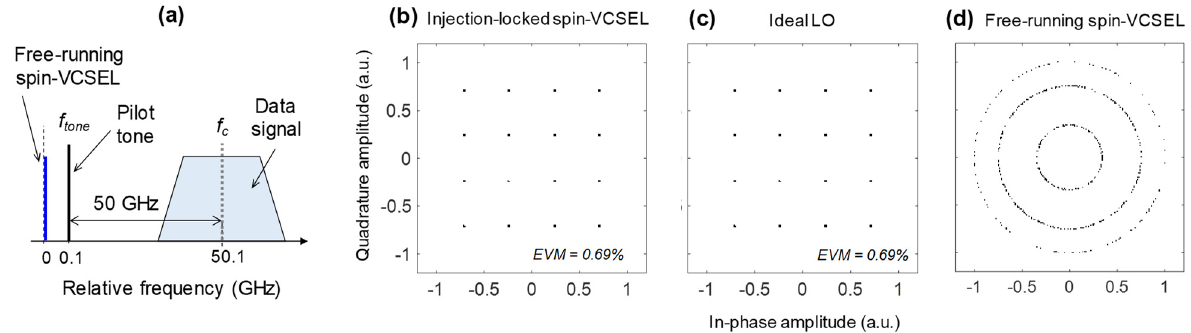
Figure 6. ( a ) Schematic relation among f c , f tone , and data signal. Constellation diagrams of detected 25-Gbaud 16-QAM signals. ( b ) With injection-locked spin-VCSEL; ( c ) With ideal LO; ( d ) With free-running spin-VCSEL.